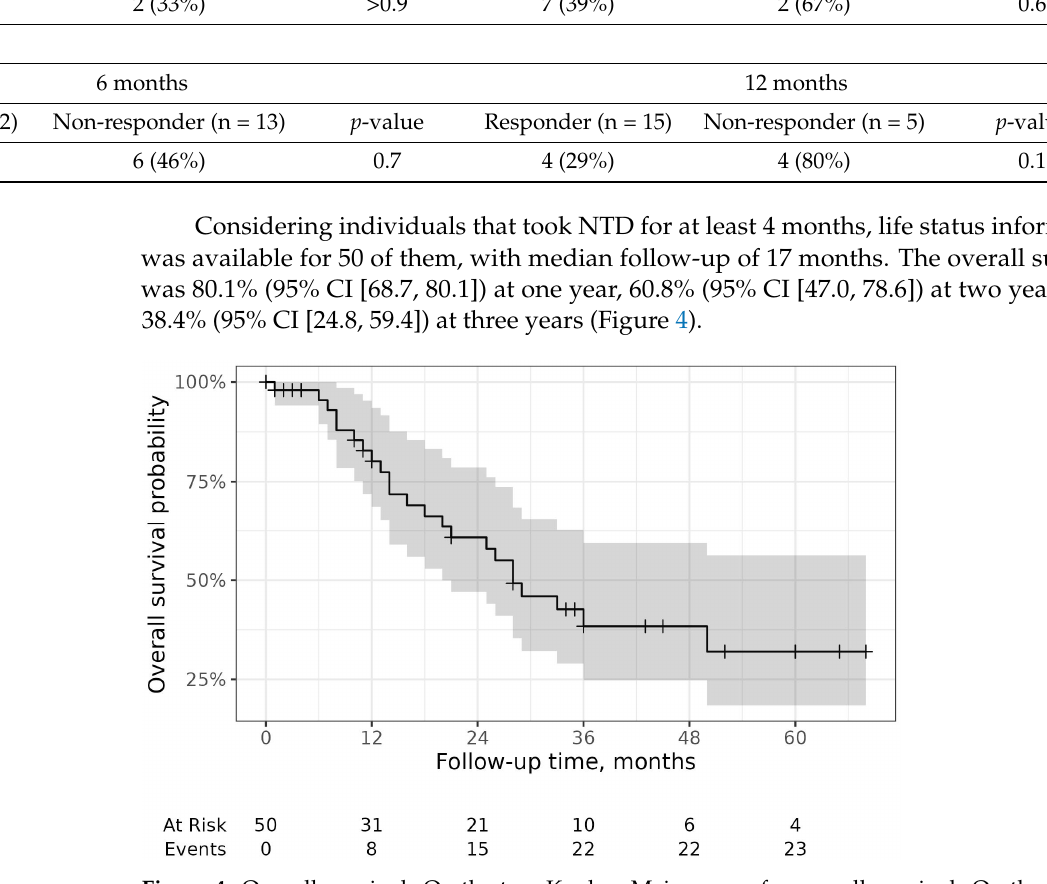
Figure 4. Overall survival. On the top, Kaplan–Meier curve for overall survival. On the bottom, number of subject at risk and number of events for each time point.